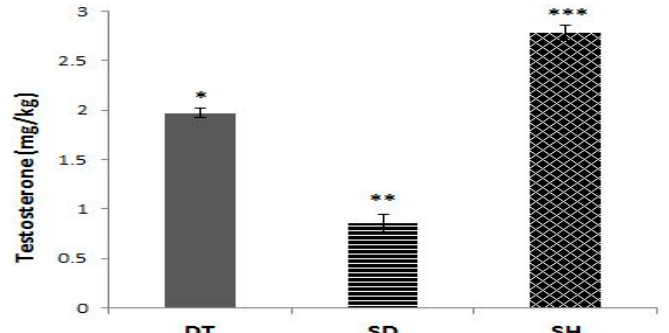
Figure 2. Different serum levels of testosterone in the DT, SD, and SH groups after six weeks of ET. *; significant difference ( p < 0.001) between DT and SD groups, **; significant difference ( p < 0.001) between SD and SH groups, ***; significant difference ( p < 0.001) between DT and SH groups. Abbreviations; DT: Diabetic training, SD: Sedentary diabetic, SH: Sedentary healthy, ET: Endurance training. Data are expressed as mean ± SEM.